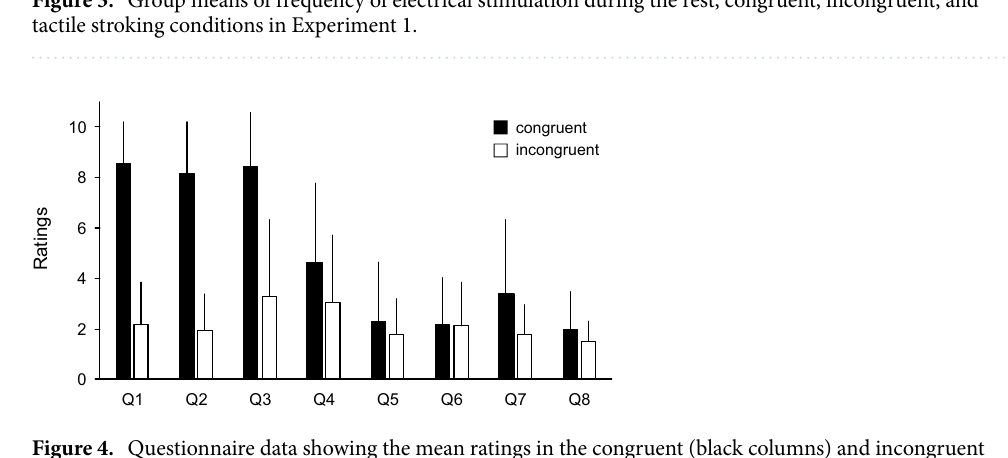
Figure 4. Questionnaire data showing the mean ratings in the congruent (black columns) and incongruent (white columns) stroking condition in Experiment 1. Ratings for the questionnaire statements on a 10-point scale ranging from 1 to 10, with 1 corresponding to strongly disagree and 10 to strongly